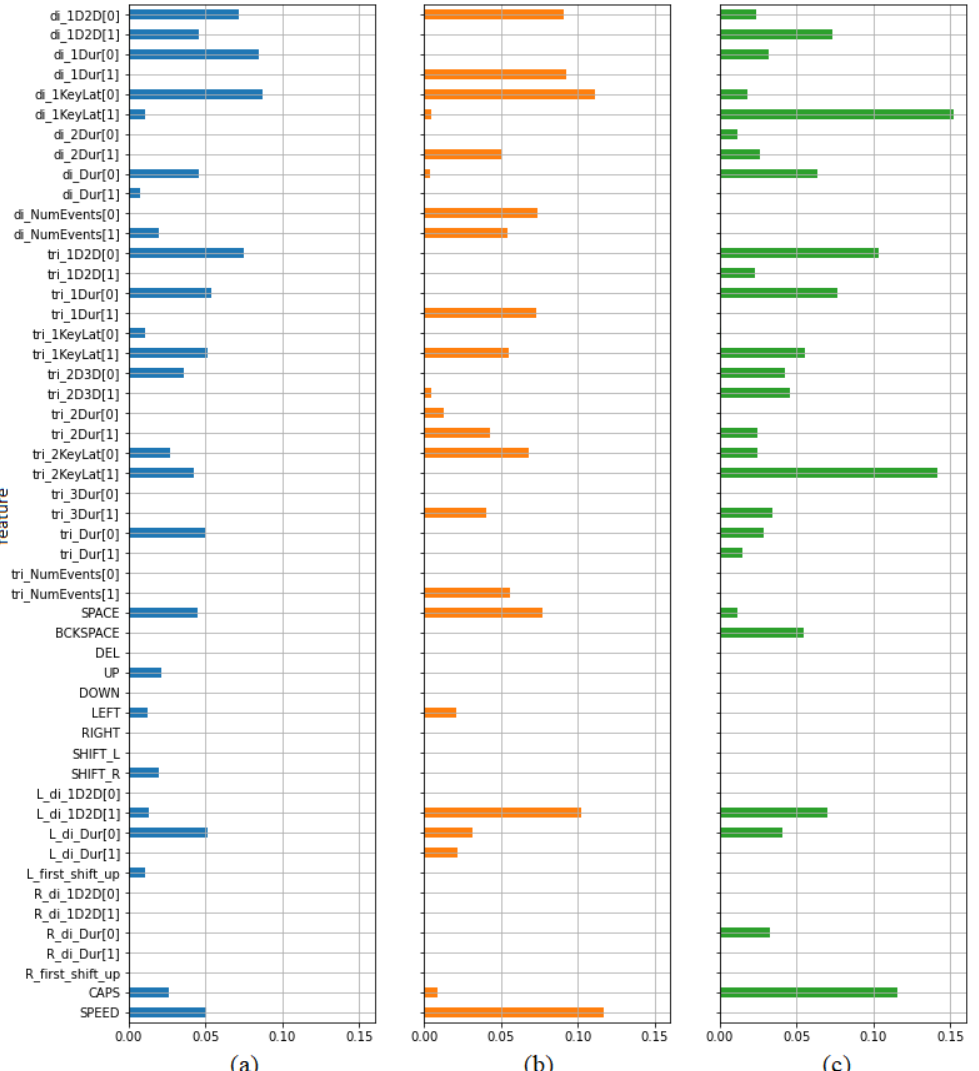
Figure 8. Mutual information values indicating the dependency between features and labels in the task of discriminating between positive and negative opinions, calculated for ( a ) all samples, ( b ) teacher samples, ( c ) subject